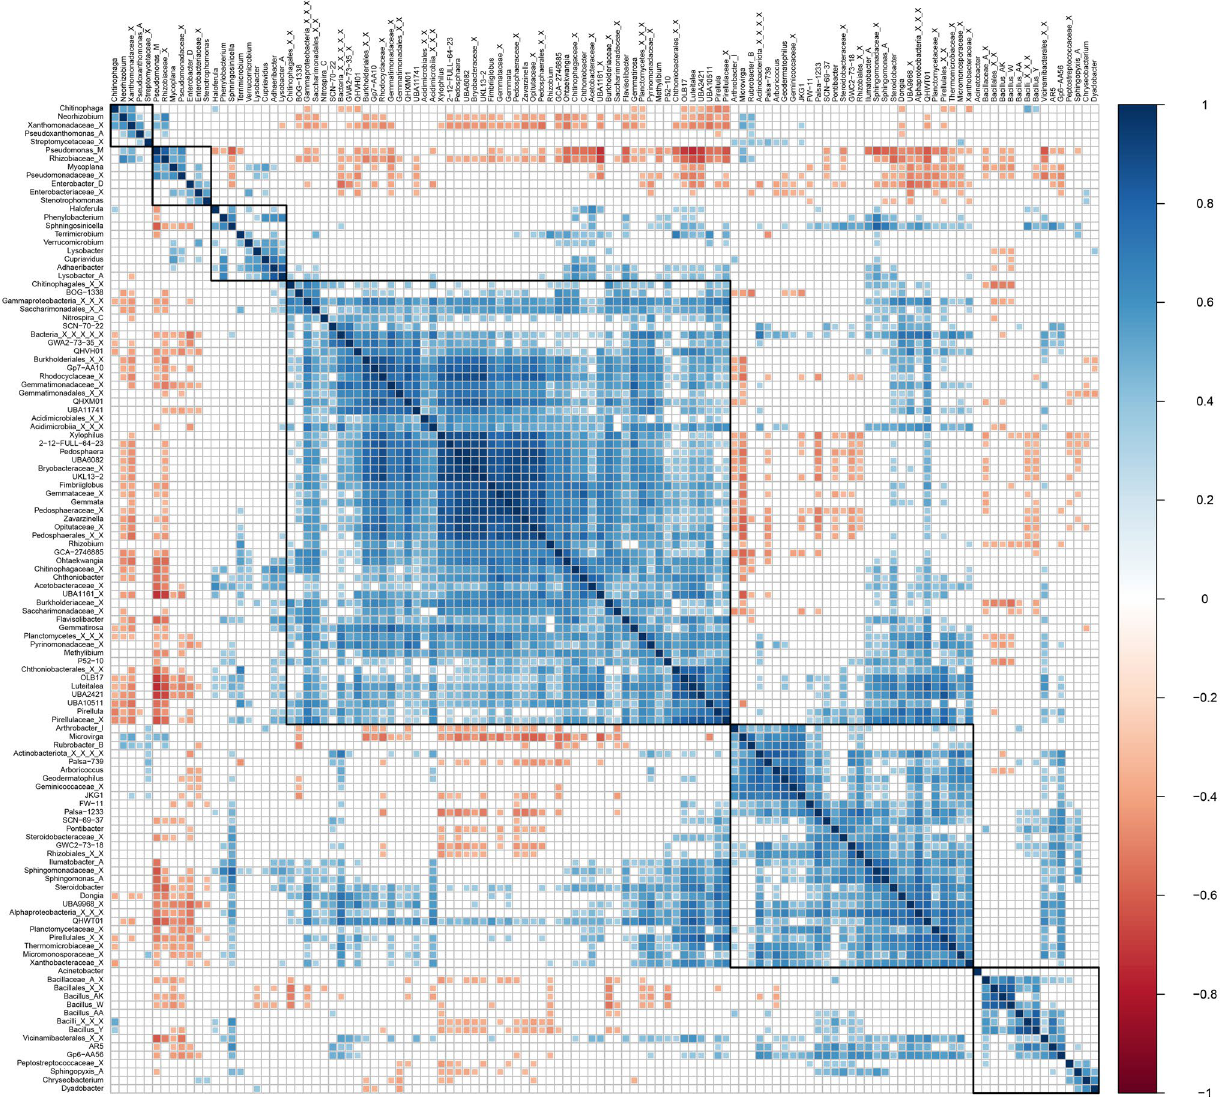
Figure 5. Correlation plot among genera from core microbiome. Only the significant (p-value < 0.05) correlations are